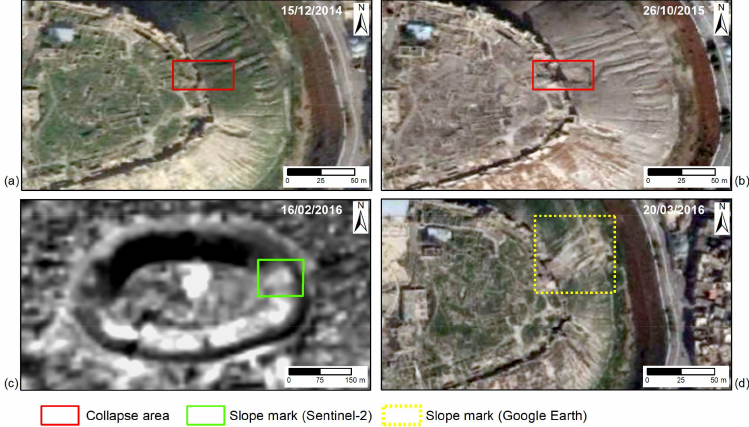
Figure 9. View of the eastern walls of the Citadel of Aleppo ( a ) several months before (15 December 2014) and ( b ) a few months after the 11 July 2015 collapse (26 October 2015). The red rectangle indicates the area affected by the collapse and the concave feature that developed on the slope after the collapse. ( c ) Grey-level representation of Sentinel-2 image acquired on 16 February 2016 with an indication of the area of higher surface reflectance probably caused by the weathering and erosion of the slope and rubble that moved further down the slope (green rectangle). ( d ) The VHR Google Earth image acquired on 20 March 2016 confirms the presence of the slope mark identified in the Sentinel-2 time series (yellow dashed rectangle). Google Earth images in ( a , b , d ) © 2018 DigitalGlobe; Copernicus Sentinel-2 image in ( c ) © 2016 European Space